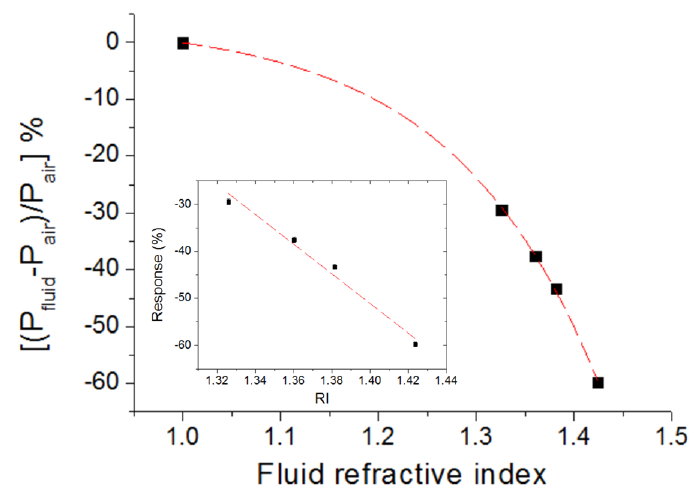
Figure 9. Relative variation of the detected power for the bent waveguide-based sensing configuration of Figure 8a as a function of the refractive index (RI) of the liquid that wets the bend. P fluid and P air are the detected powers when the bend is immersed in a fluid and air, respectively. The experimental data can be well fitted by an exponential function (dashed line) with adjusted R 2 = 0.999. Error bars are equal or smaller than the dot size. Inset shows the measured values in the RI range 1.326–1.424 and a linear fit of the data (dashed line).